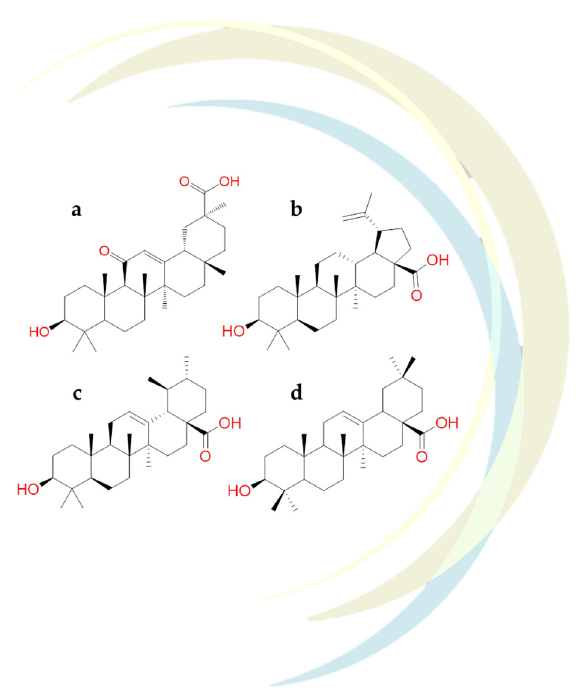
Figure 15. 2D structures of ( a ) glycyrrhetinic acid, ( b ) betulinic acid, ( c ) ursolic acid, ( d ) oleanolic acid.